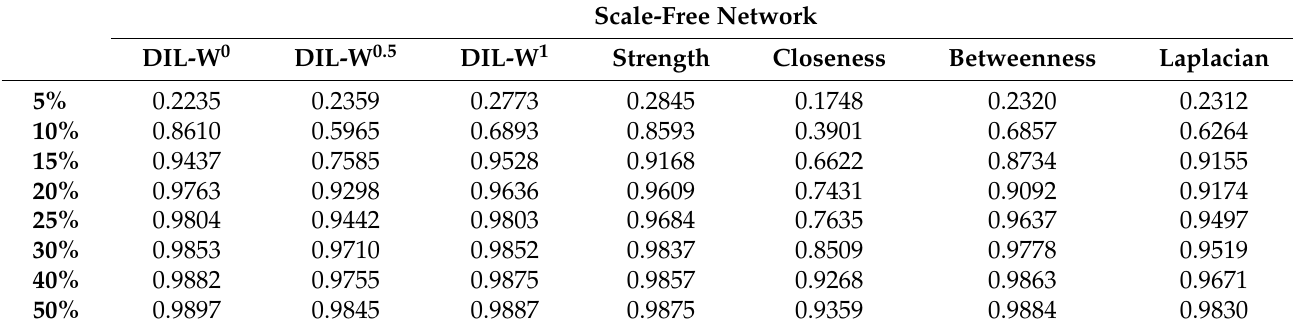
Table A5. σ according to different values of k in a Scale-free Network.